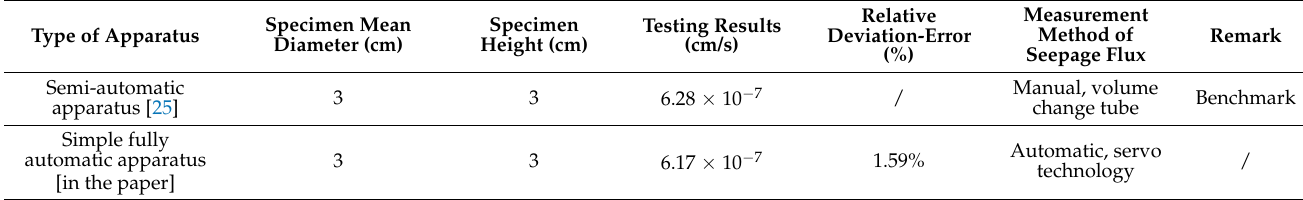
Table 5. Results of the seepage coefficient of a plastic concrete cutoff